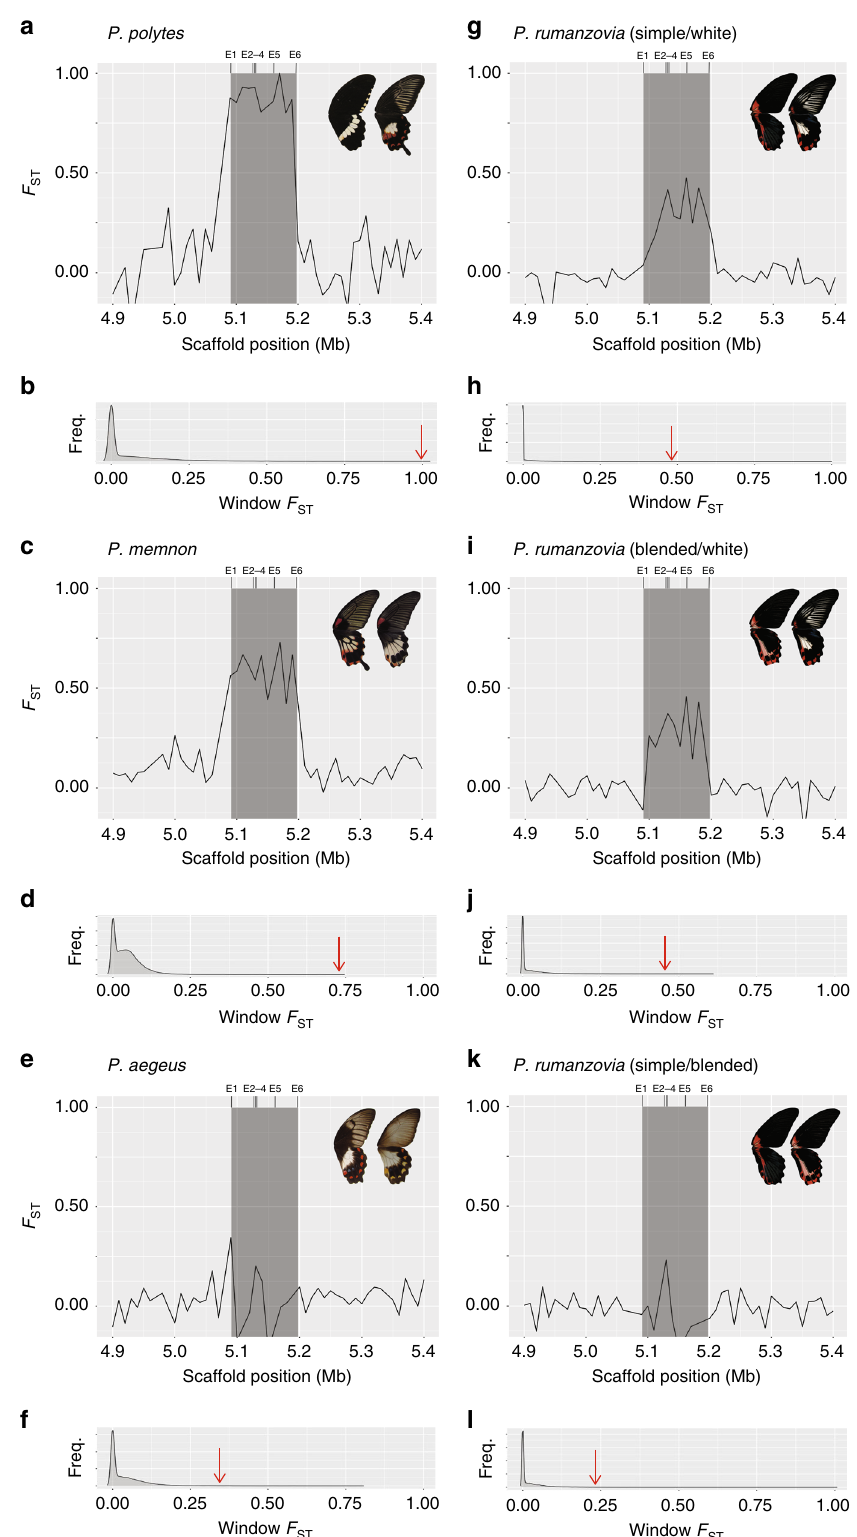
Fig. 3 Genetic differentiation between morphs. F ST across a 500 kb interval containing dsx (gray box) in P. polytes ( a ), P. memnon ( c ), P. aegeus ( e ), and P. rumanzovia ( g , i , k ). E1 – 6 indicate the position of dsx exons. Genome-wide F ST distribution in P. polytes ( b ), P. memnon ( d ), P. aegeus ( f ), and P. rumanzovia ( h , j , l ). Red arrows indicate the highest F ST value for dsx windows, all of which are in the 99th percentile of their respective